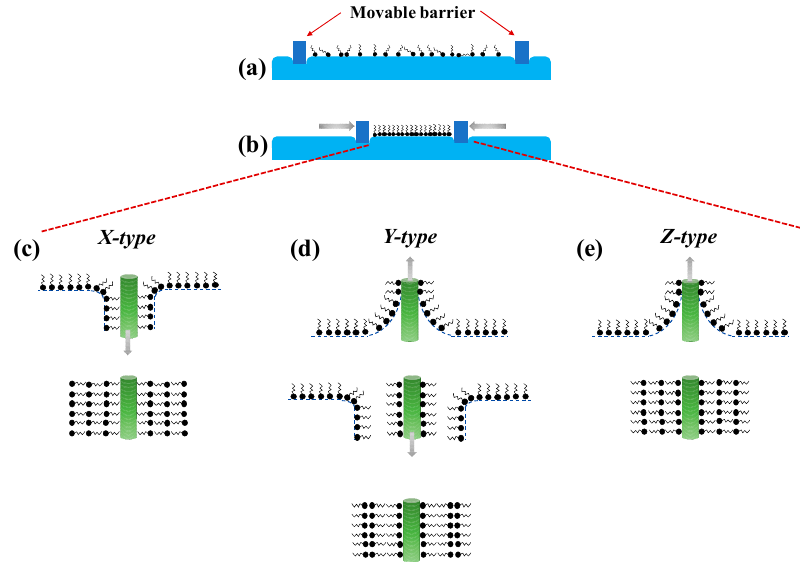
Figure 3. Langmuir-Blodgett film deposition scheme. ( a ) Spreading of molecules to the surface of sub-phase, ( b ) surface compression with constant pressure to yield a condensed and stable monolayer film, ( c ) X-type LB film deposition, ( d ) Y-type LB film deposition, and ( e ) Z-type LB film deposition.